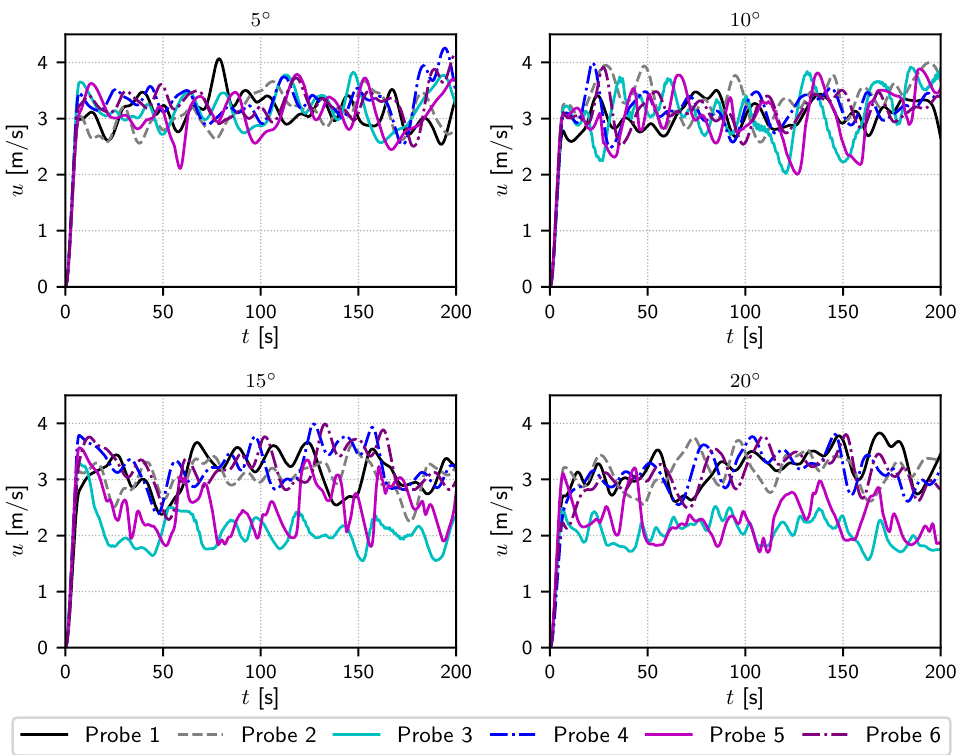
Figure 16. Velocity u measured by six numerical probes, for four yaw angles ( I ∞ = 10%, L = 18 m, Rf ≈ 229, TSR = 4.1, σ ( λ ) = 75%)